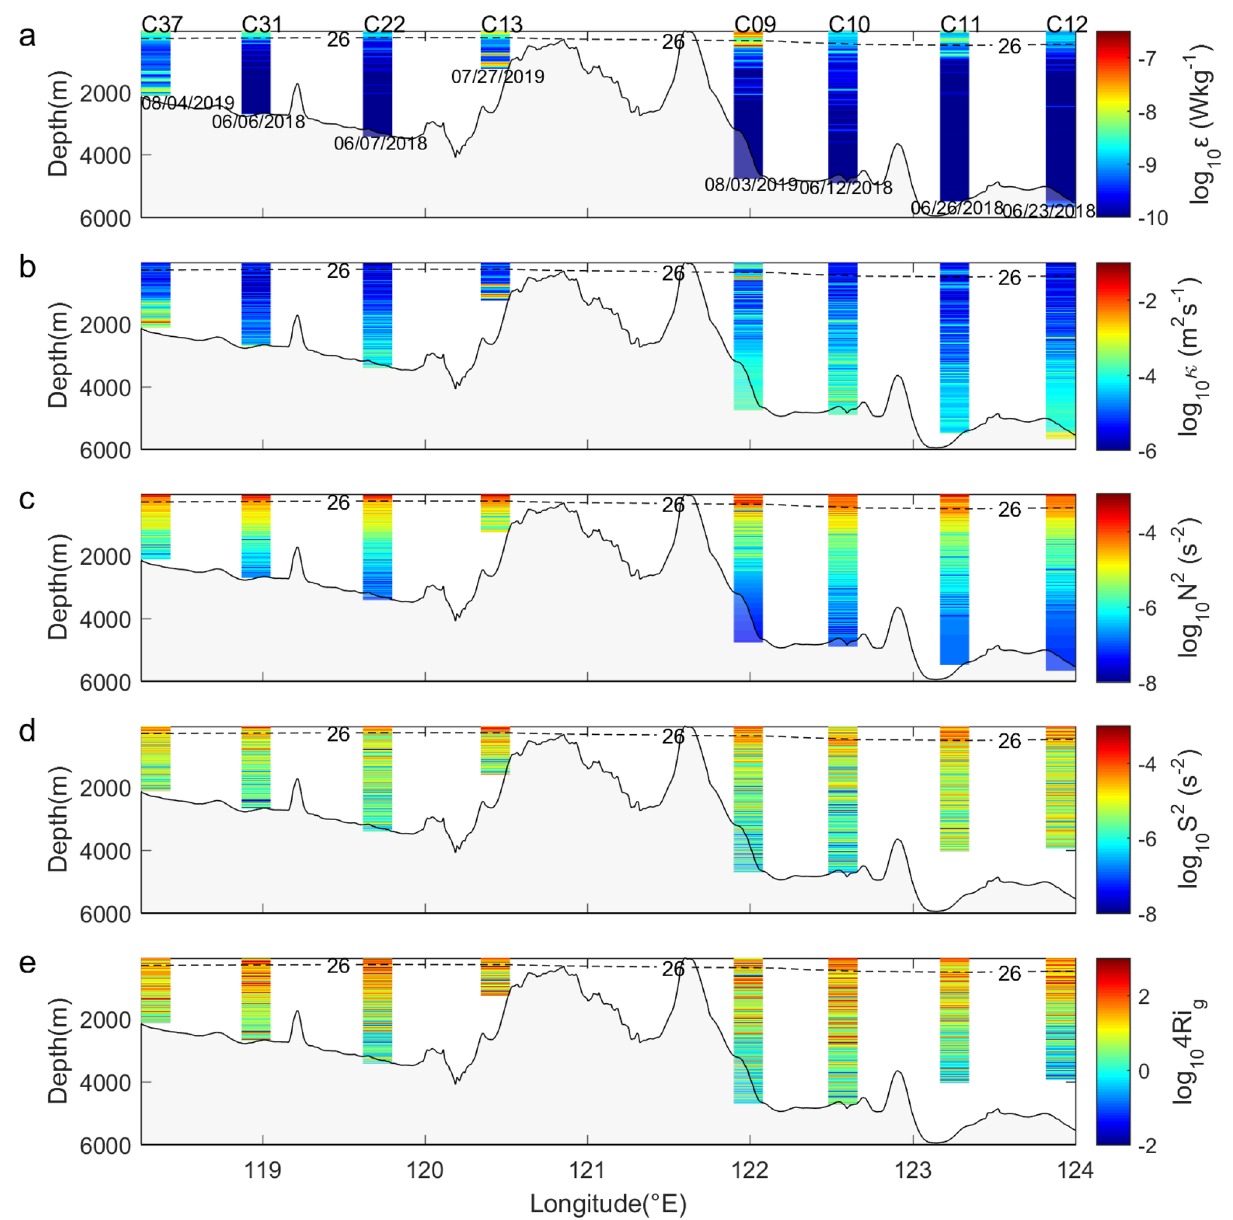
Figure 2. ( a ) Dissipation rate ( ε ), ( b ) diapycnal diffusivity ( κ ), ( c ) squared buoyancy frequency ( N 2 ), ( d ) shear squared ( S 2 ) and 4 times the gradient Richardson number ( e ) for the NSCS-WP cross-section in Fig. 1. The gray shading indicates bathymetry. In ( a – e ), the boundaries of the thermocline upper layer are taken as the 26- σ θ isopycnal (dashed line), and the bin size is 10 Vertical distributions of turbulence along the NSCS-WP cross-section. Cross-section along 21° N is widely used to compare turbulent mixing of the NSCS and WP 9,18 since the internal tide energy flux is strongest within a beam that emanates from the LS between 20° N and 21° N. Cross-section NSCS-WP (red line in Fig. 1a), which is near cross-Sect. 21° N, was chosen to present the full-depth microstructure measurements (Fig. 2). Because depths in the NSCS and WP are different, by defining layers based on depth, one may bring unfair comparisons by comparing bottom-enhanced turbulence (500–1500 m in the NSCS) with mild turbu- lence in the middle layer (500–1500 m in the WP). Considering that turbulence is usually enhanced at the upper and bottom layers, three layers were defined, including the upper layer (50 m to the 26- σ θ isopycnal 23 ), middle layer (the 26- σ θ isopycnal to 500 m above the bottom) and bottom layer (within 500 m above the bottom 3,19 ). Generally, the ε in the upper layer was higher than that in the other layers, with a maximum value of 1.32 × 10 –7 Wkg −1 at C09 (Fig. 2a). Strong fine-scale velocity shear (Fig. 2d) was also observed in the upper layer. Similar Ri g patterns (Fig. 2e) implied that shear instability played an important role in driving upper layer dissipation. In contrast to ε , the κ (Fig. 2b) of all three layers was weakest in the upper layer (10 –6 –10 –5 m 2 s −1 ), where κ